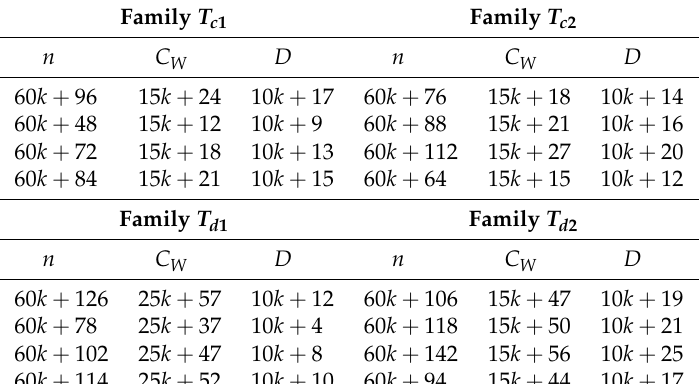
Table 5. Parameters of fullerene graphs with n ≤ 232 vertices and caps of types c and d ( k ≥ 0).